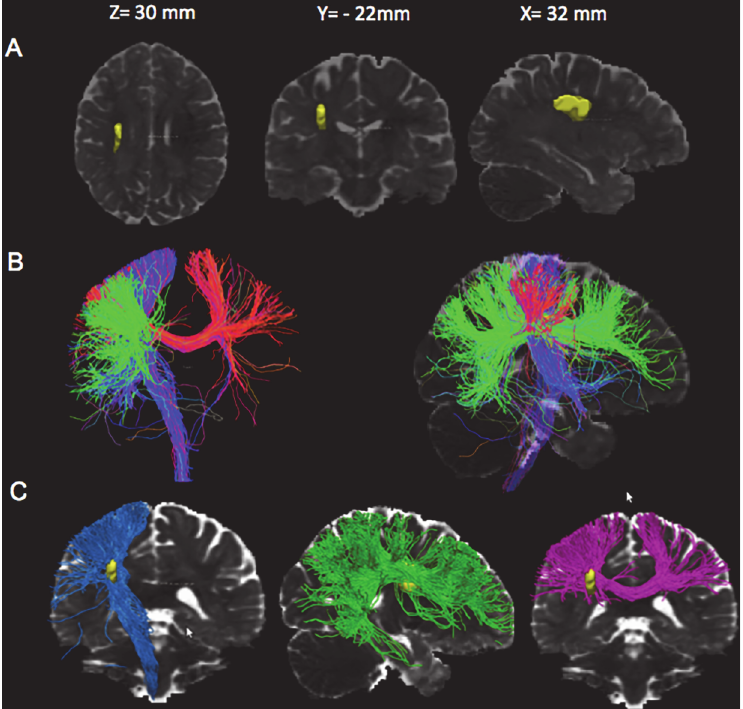
Fig 3. Tracking analysis from the strategic area. Color code is directional (blue for z-axis, green for y-axis and red for x-axis). A. Superposition of the strategic area (in yellow) on a normalized ADC map. B Association and Projection tracts passing through the strategic area on a coronal view (left image) and on a sagittal view of a normalized ADC map. The color code is directional (pink for the x-axis, blue for z-axis and pink for y-axis). C. Association and Projection tracts travelling though the strategic area (in yellow). Left: The projections tract projections at the top in the following areas: primary motor, premotor, and parietal cortices (blue); Middle: The association tract passing through the yellow region contains part of the superior longitudinal fasciculus (green); Right: The fibers of the corpus callosum passing through the strategic area